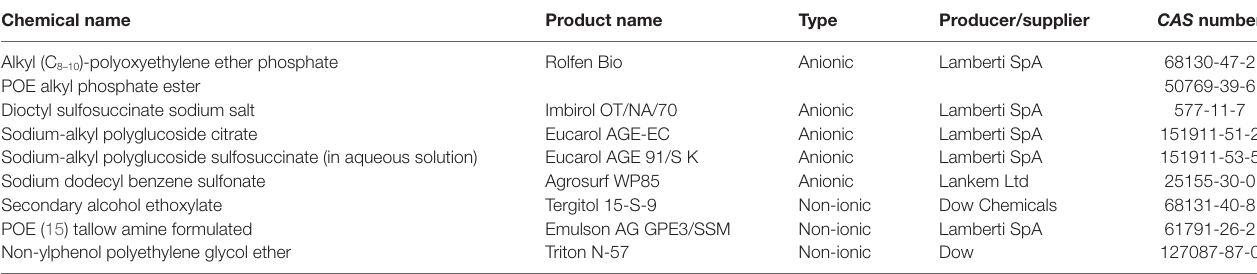
TABLe 4 | Various types of surfactants used in plant protection